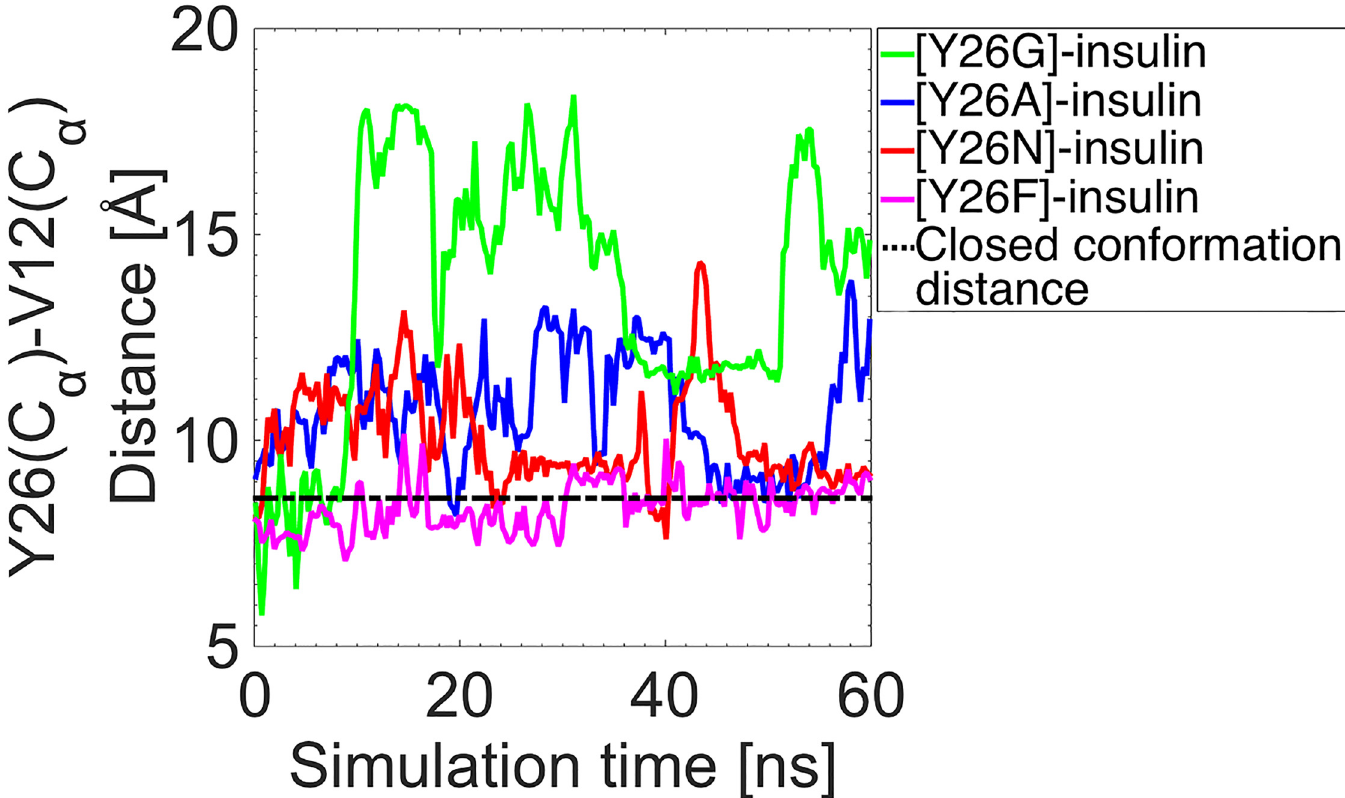
Fig 8. Effect of Y26 mutations on the BC-CT opening. The distance between the C α atoms of the Y26 – V12 residues, which determines the criterion for the BC-CT opening, for the Y26G, Y26A, Y26N and Y26F mutations. The closed conformation distance in WT insulin is shown for reference (black dashed line).